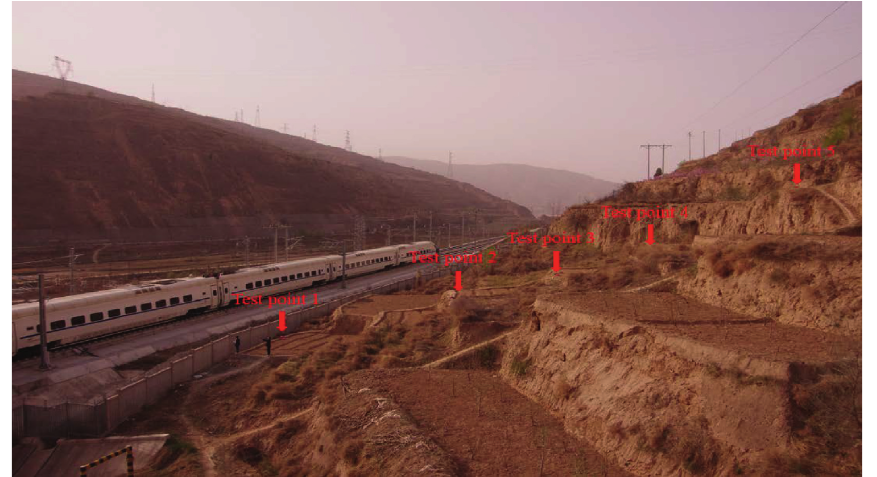
Figure 2: Field test overview.